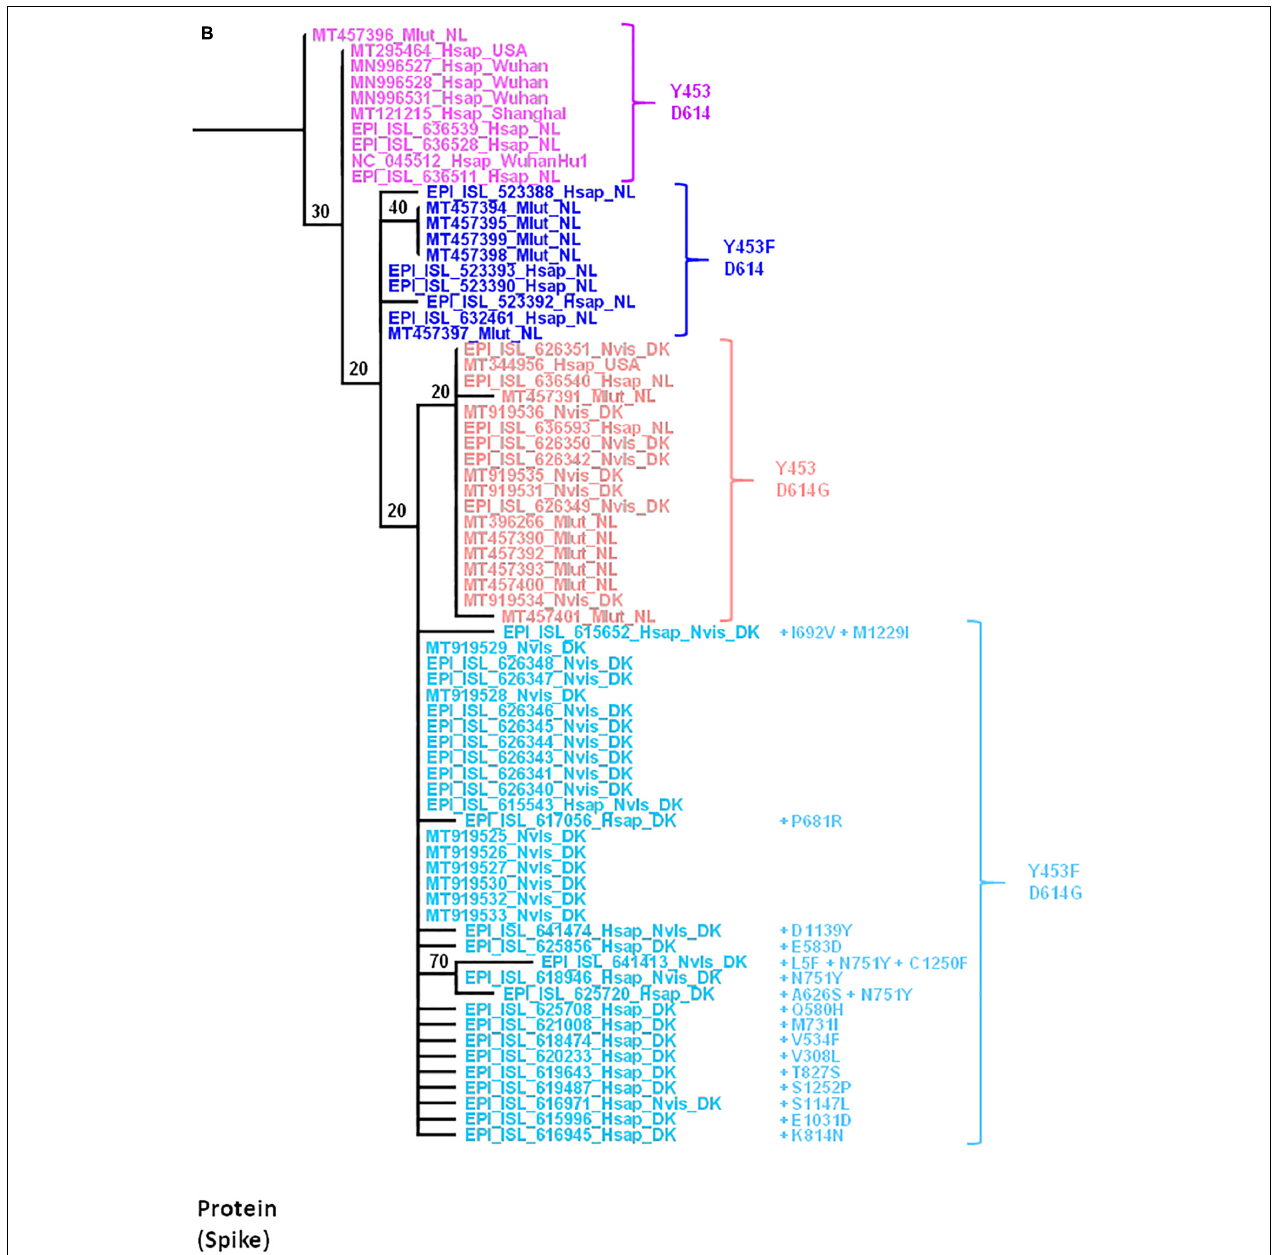
FIGURE 7 | (A) Maximum likelihood (GTR+R) phylogenetic tree of the SARS-CoV-2 spike gene from different isolates. Sample names are built with the GISAID or GenBank accession number followed by a four-letter code (Mlut, Nvis, and Hsap) identifying the species followed by a code indicating the geographical origin of the sample. The tree was rooted using the spike gene and protein sequence of the Wuhan Hu1 SARS-CoV-2 strain. (B) Maximum likelihood (LG) phylogenetic tree of SARS-CoV-2 spike glycoprotein from the different isolates.